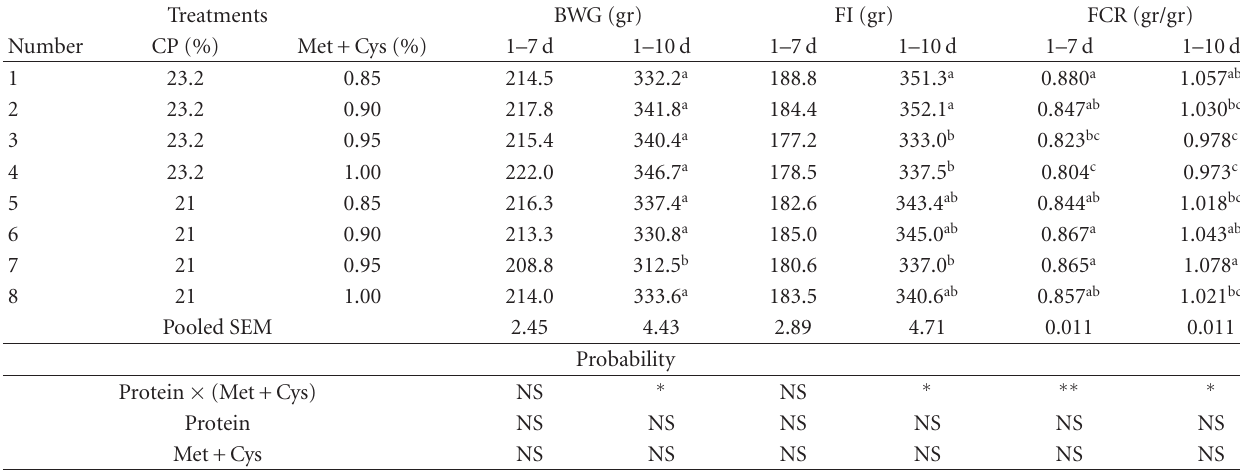
Table 4: E ff ect of feeding diets containing various levels of crude protein (CP) and methionine+cystine (Met+Cys) on body weight gain, feed intake, and feed conversion ratio of broiler chicks (Experiment